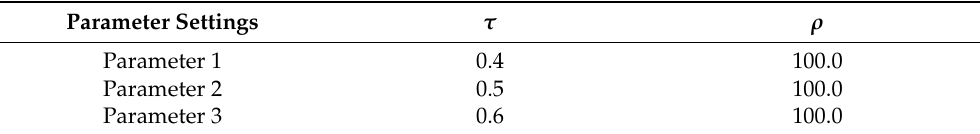
Figure 10. The influence of different parameter Settings on DCNG model in MFPT data set. Table 6. Different parameter settings on the MFPT data set. Parameter